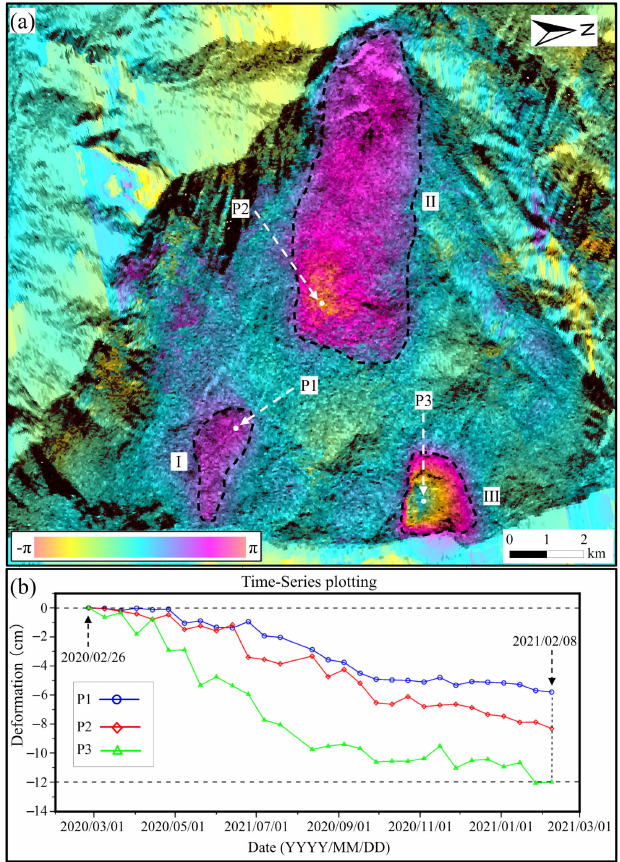
Figure 3. Time series InSAR displacement distribution of the Niexia slope: ( a ) cumulative displace- ment obtained by the Stacking-InSAR technique; ( b ) time series displacement of P1, P2, and P3.